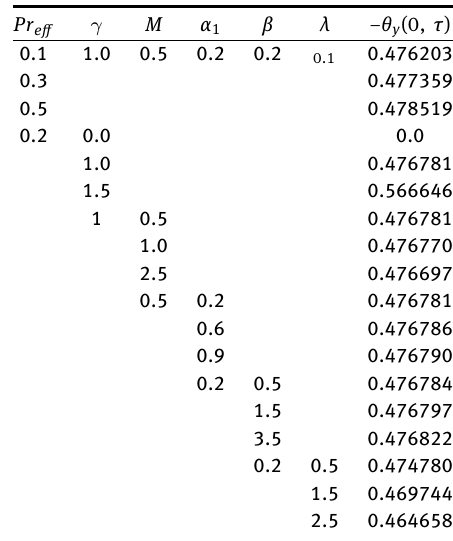
eff , M , β and 𝛾 when S